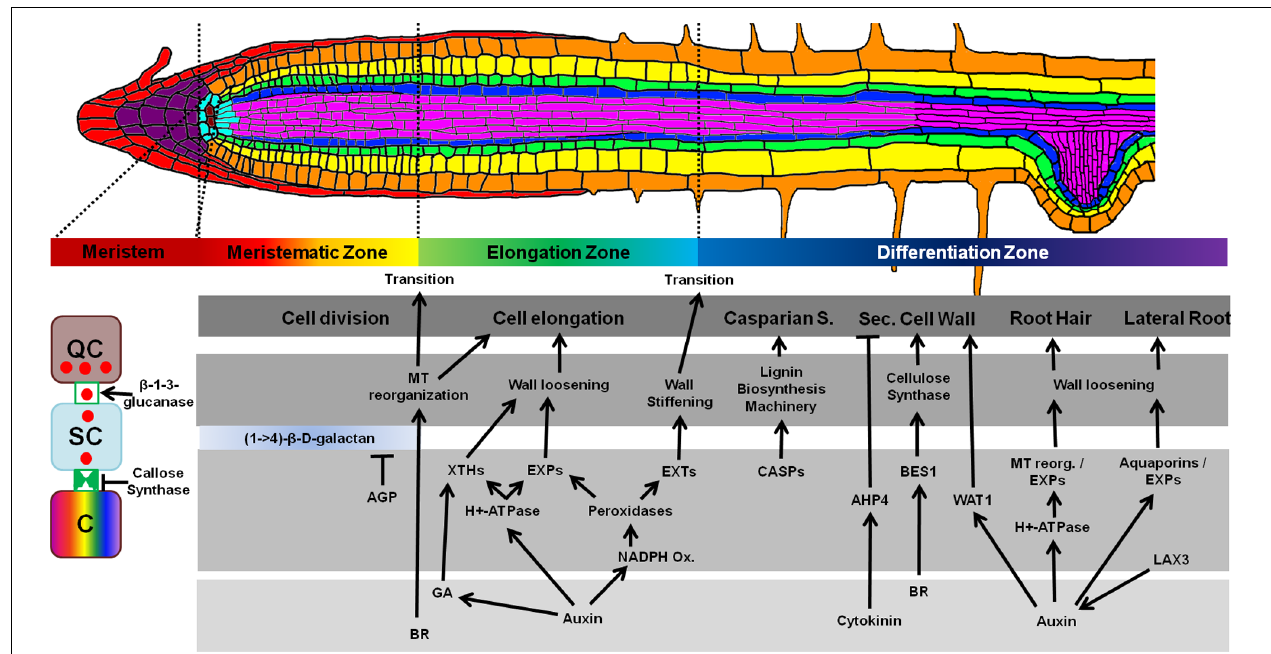
FIGURE 1 | Arabidopsis root architecture and processes that influence cell wall deposition. Upper panel; different developmental zones of the root are shown from the meristem (dark red) to DZ (dark blue). Lower panel: (dark gray box), characteristics of each zone are indicated (cell division, cell elongation, etc.), followed by associated cell wall modifications (lighter gray box) and proteins, and the underpinning hormone signaling pathways (lowest, light gray box). Far left panel, a QC-derived signal (red circles) might move to neighboring stem cells (SCs), possibly through PD to maintain stem cell fate, but is blocked from further travel to the stem cell daughter cell (C) by PD exclusion. AGP, arabinogalactan-protein; XTHs, xyloglucan endotransglycosylases/hydrolases; EXP, expansins; EXT, extensins; CASPs, CASPARIAN STRIP DOMAIN PROTEINS; AHP4, ARABIDOPSIS HISTIDINE - CONTAINING PHOSPHOTRANSFER FACTOR 4; BES1, BRI1-EMS-SUPPRESSOR1; WAT1, WALLS ARE THIN1; BRs, brassinosteroids; GAs, gibberellins.